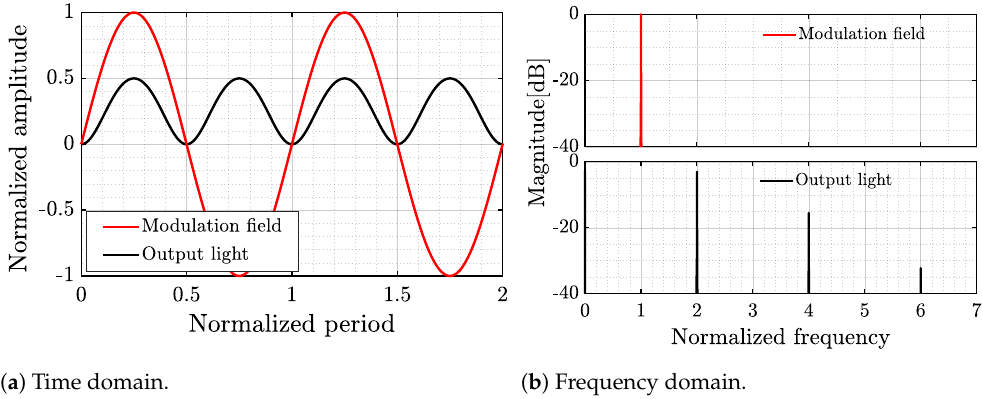
Figure 5. E MOD and output light intensity with no electric field incident on the second crystal.